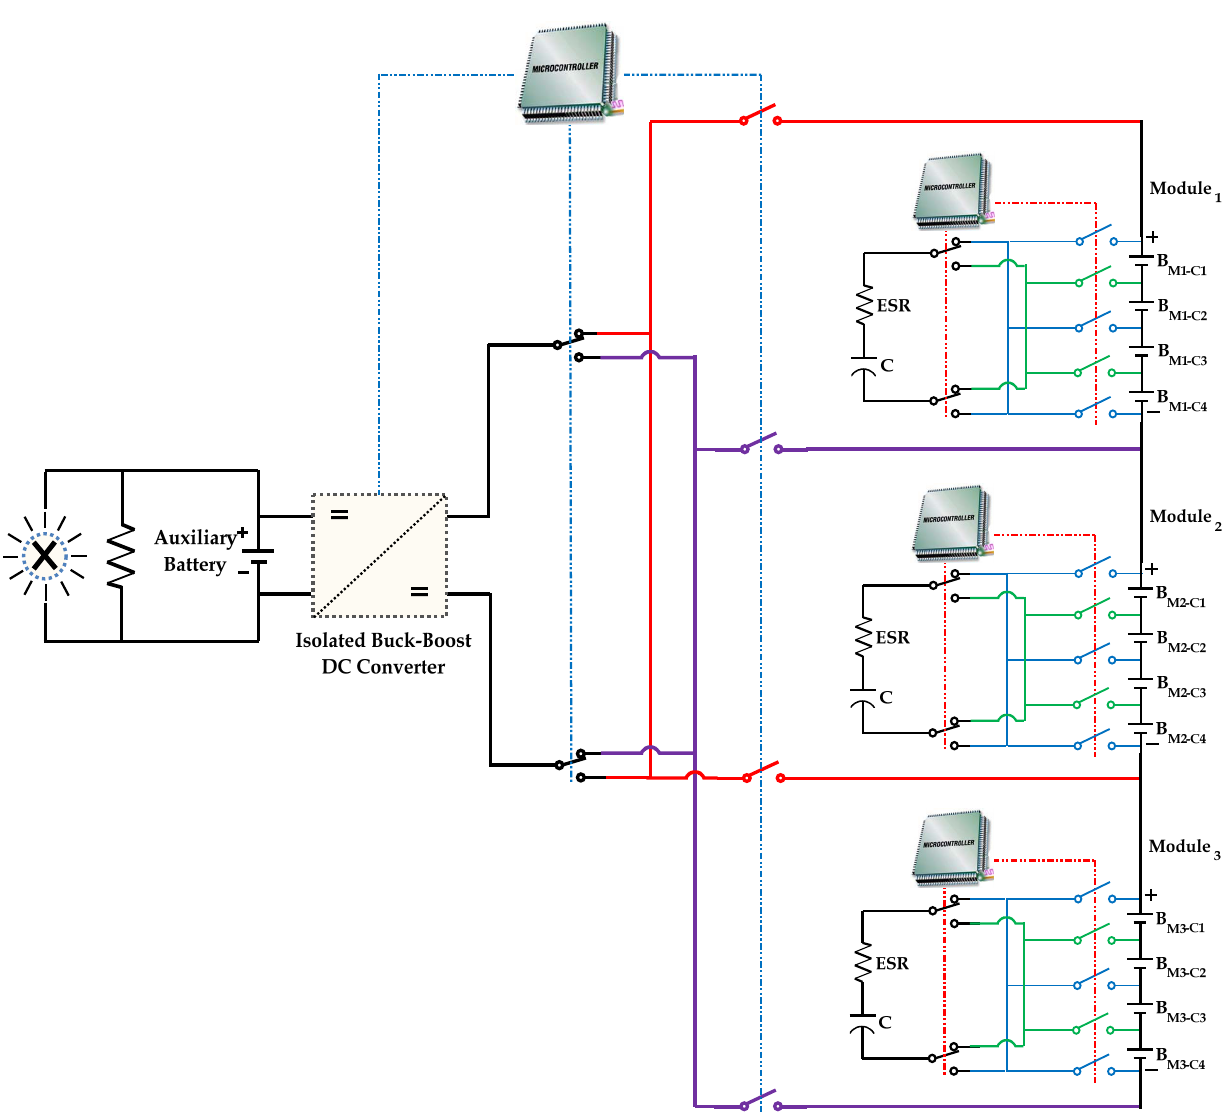
Figure 4. Proposed modularized balancing